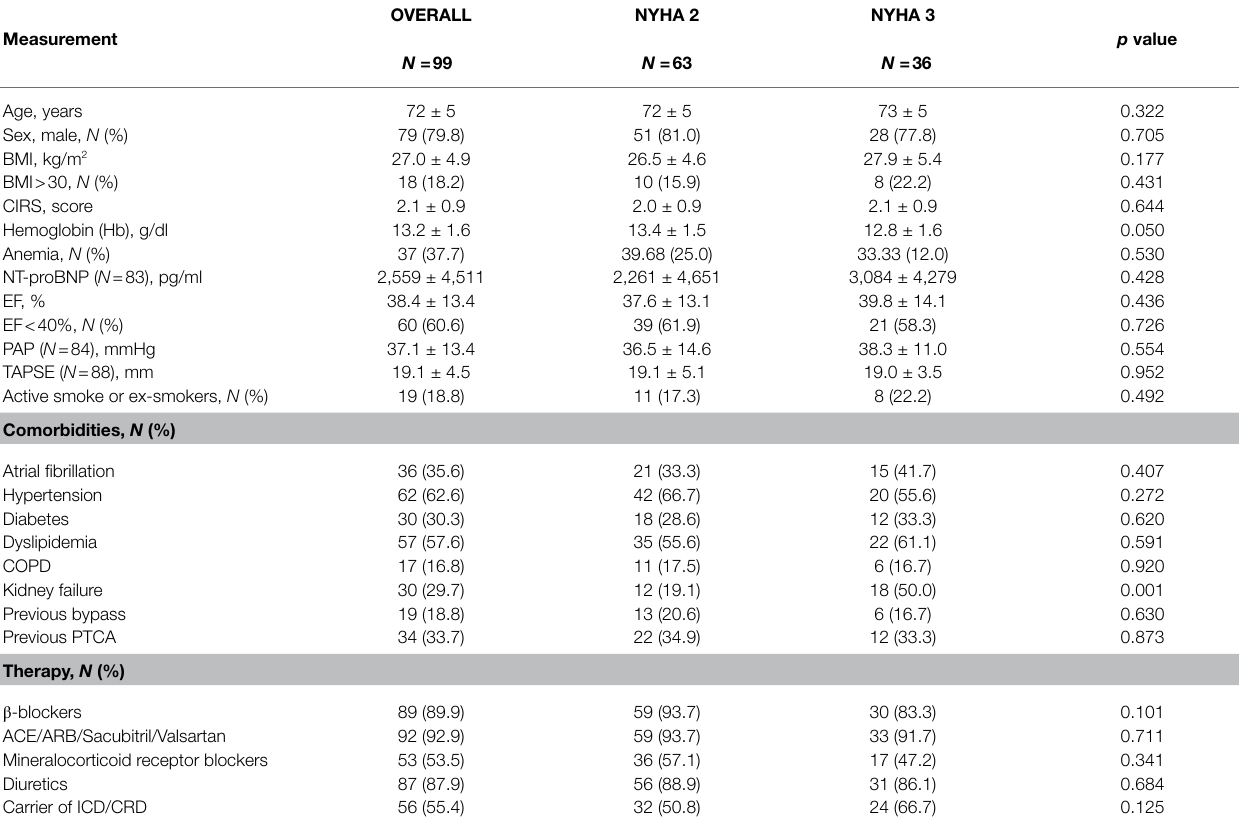
TABLE 1 | Demographic and clinical characteristics of patients enrolled.